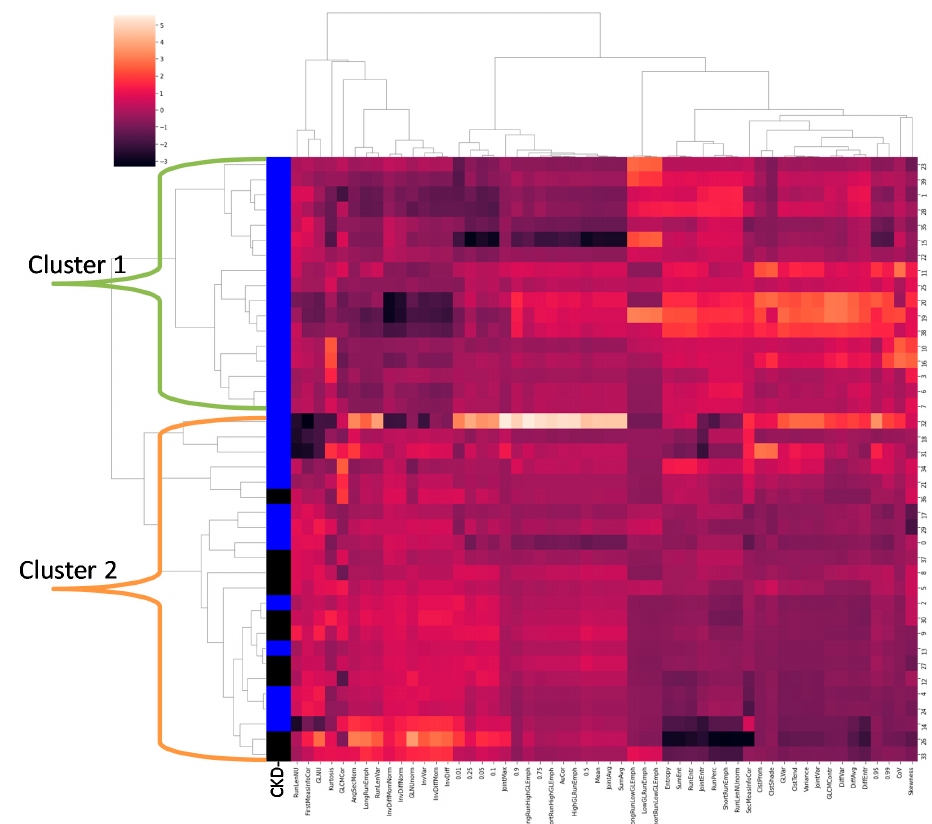
Figure 5. Hierarchical clustering of radiomic features. Shown are Z-score normalized values of each individual radiomic feature in each column, with each participant as a unique row. The first column represents the presence (blue) or absence (black) of CKD in the subject. The clustering shows two distinct phenotypes. Phenotype 1 (Cluster 1) can be identified as CKD, while phenotype 2 (Cluster 2) includes both CKD and controls, possibly indicating early changes. Cluster 1 had more negative Z-scores (darker red) in many of the first 29 feature columns and more positive Z-scores (lighter red) in the following 25 feature columns.